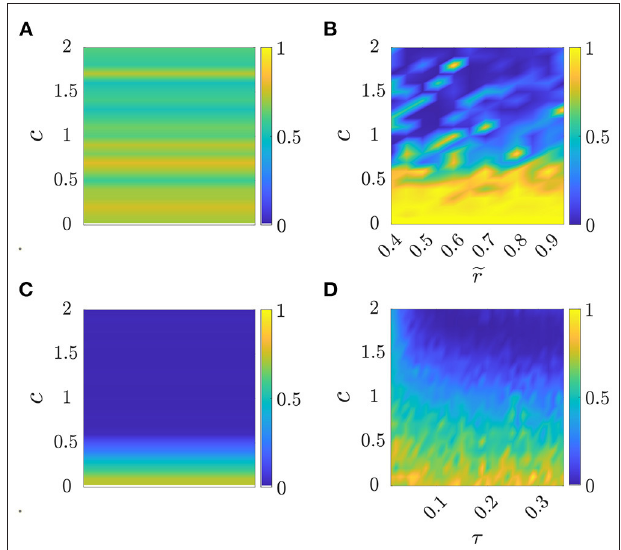
FIGURE 2 | Cost function J m as a function of parameter selection, see Section 4.2.1. Panel (A) corresponds to Standard Kuramoto ( 5 s = { c } ), (B) to r } ), (C) to Model 2 ( 5 2 = { c } ), and (D) to Model 3 Model 1 ( 5 1 = { c , ( 5 3 = { c , τ } ). The values of the cost function J m are averaged over 10 e simulated trials in each parameter set A m , see Table 3 for the optimal parameter values for each model.